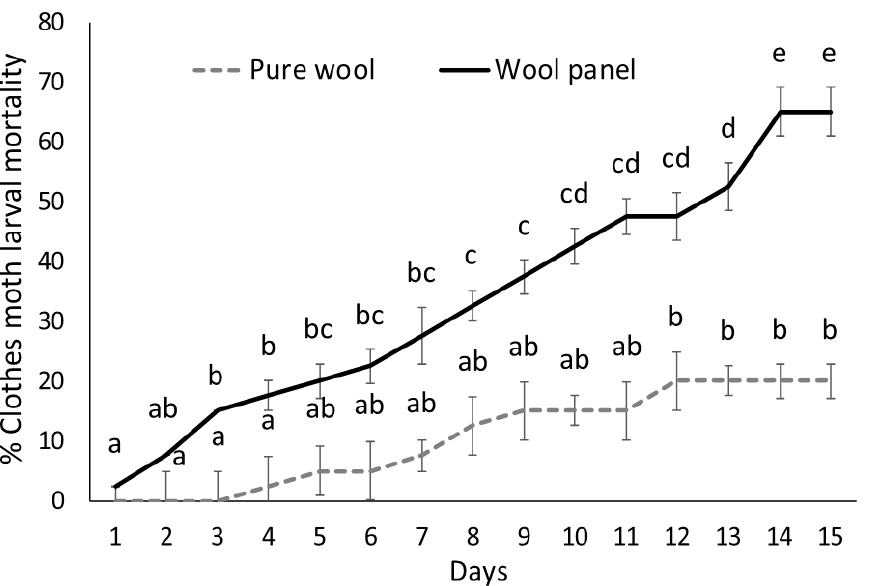
Figure 3. Over time mortality (mean percentage ± SE) of clothes moth larvae exposed to the commercial wool panel compared with pure wool. Different letters indicate significantly different means (ANOVA Mixed Proc., Tukey adjusted p < 0.05).